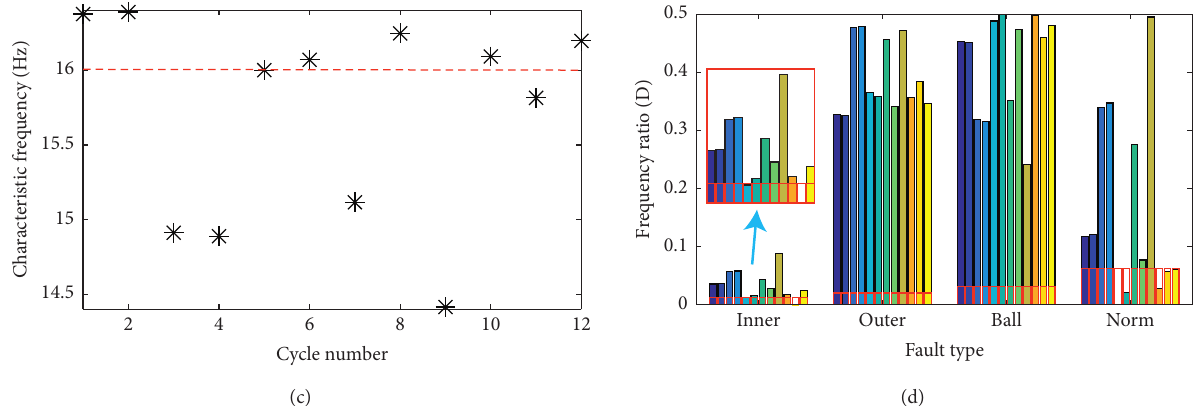
Figure 17: The diagnosis process of normal bearing: (a) the original signal; (b) the reconstructed signal; (c) characteristic frequency in each cycle; (d) the frequency ratio of fault types in each